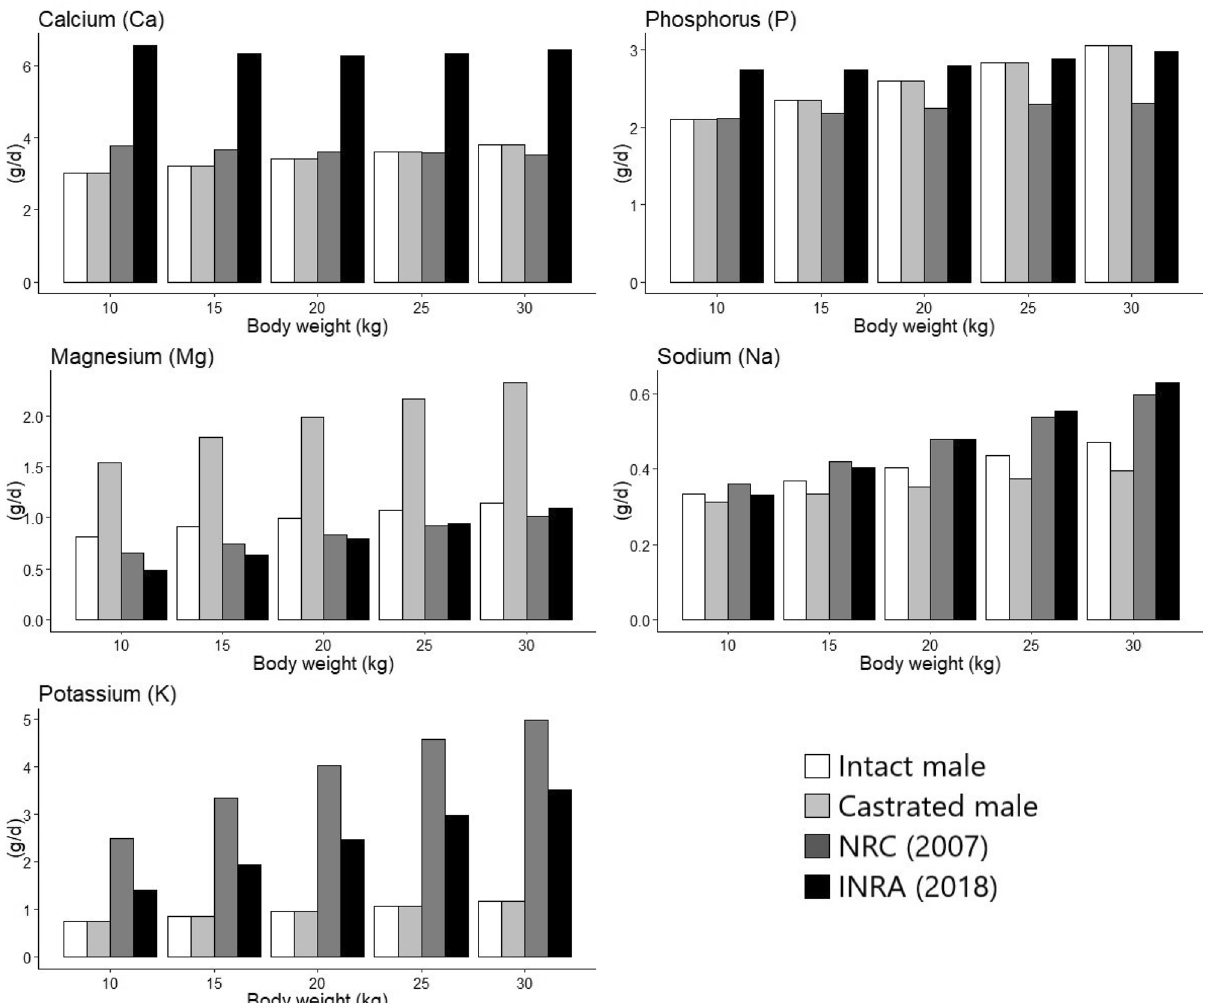
Figure 1. Comparison of total dietary macromineral requirements among the obtained results and the committees (INRA 6 and NRC 3